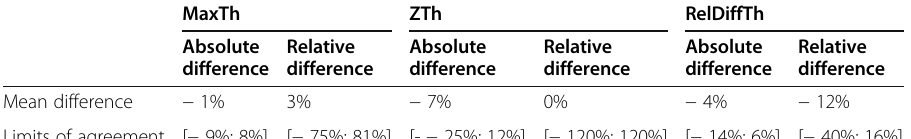
Table 1 Bland and Altman analysis: mean absolute and relative differences, with limits of agreement for the three segmentation methods MaxTh ZTh RelDiffTh Absolute Relative Absolute Relative Absolute Relative difference difference difference difference difference difference Mean difference − 1% 3% − 7%